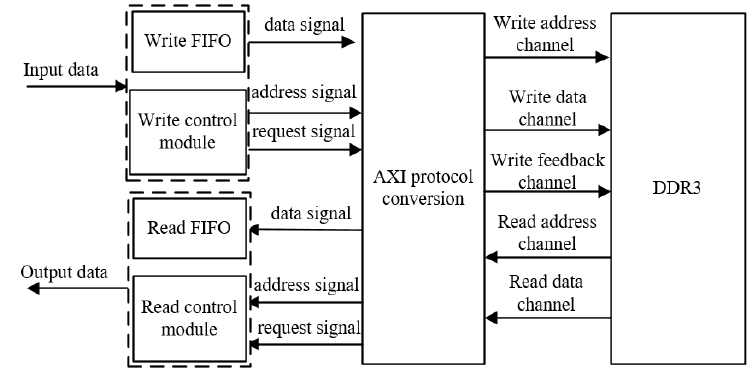
Figure 5. General block diagram of image-data caching and